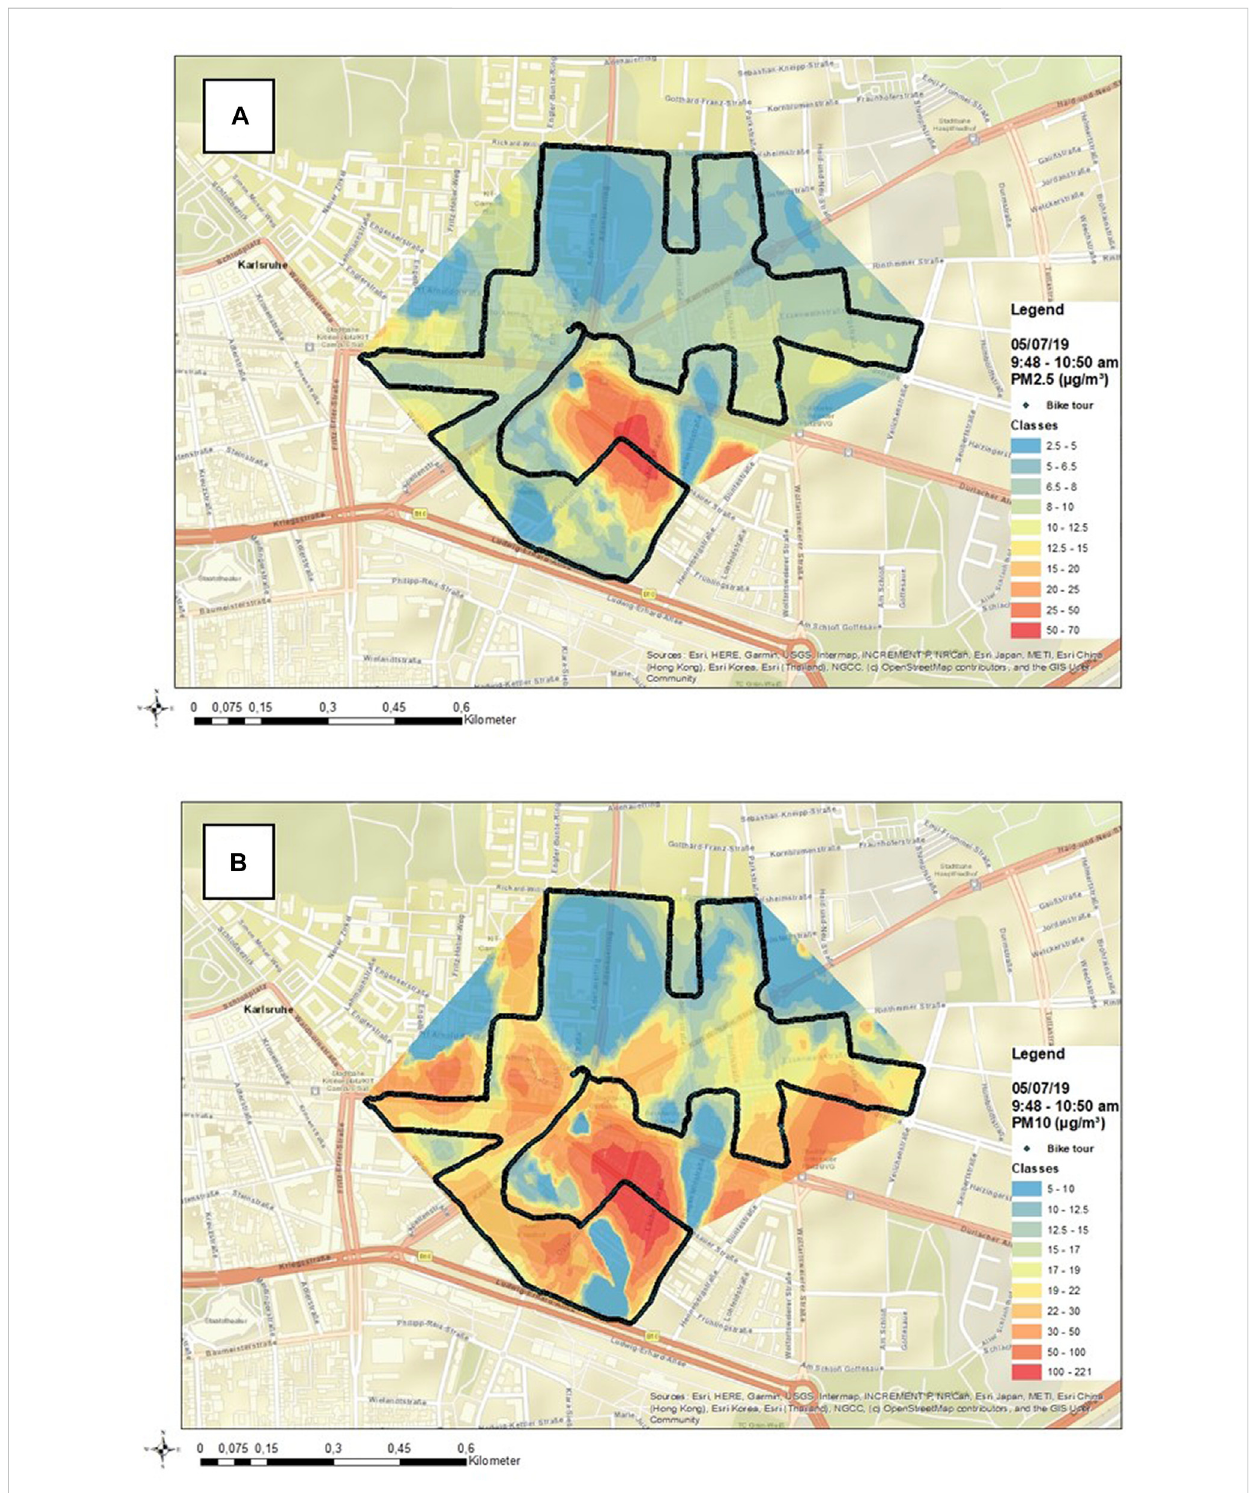
FIGURE 6 (A) PM 2.5 concentration pattern on 5th of July 2019, 9:48